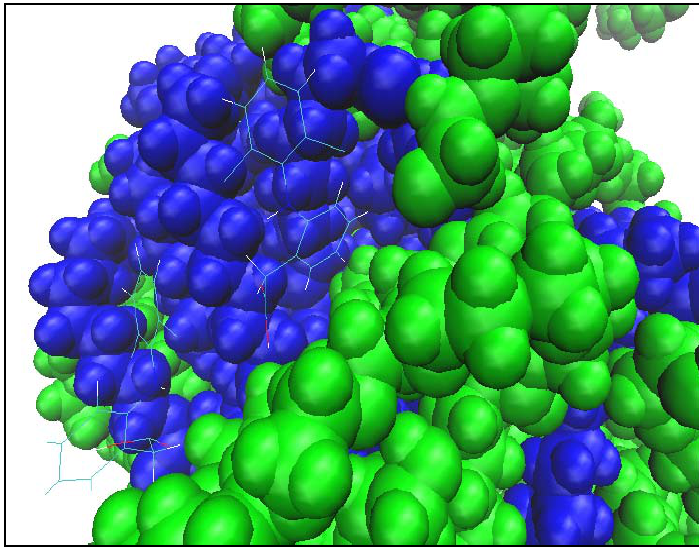
Figure 4. Close-up of a typical conformation of diclofenac molecules (upper) and of oleyl palmitate and Tween80. For the basic color scheme, see caption of Figure 2. Additionally, all oxygens were colored red and hydrogens of the hydroxyl groups white to illustrate the hydrogen